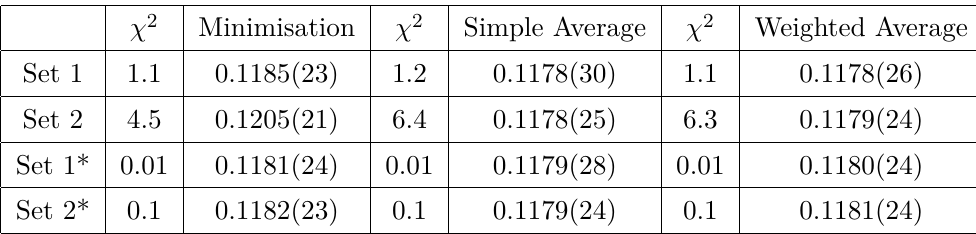
Table 11 . Averaged results for α ( n f =5) s ( M 2 the same source are assumed to be fully correlated.